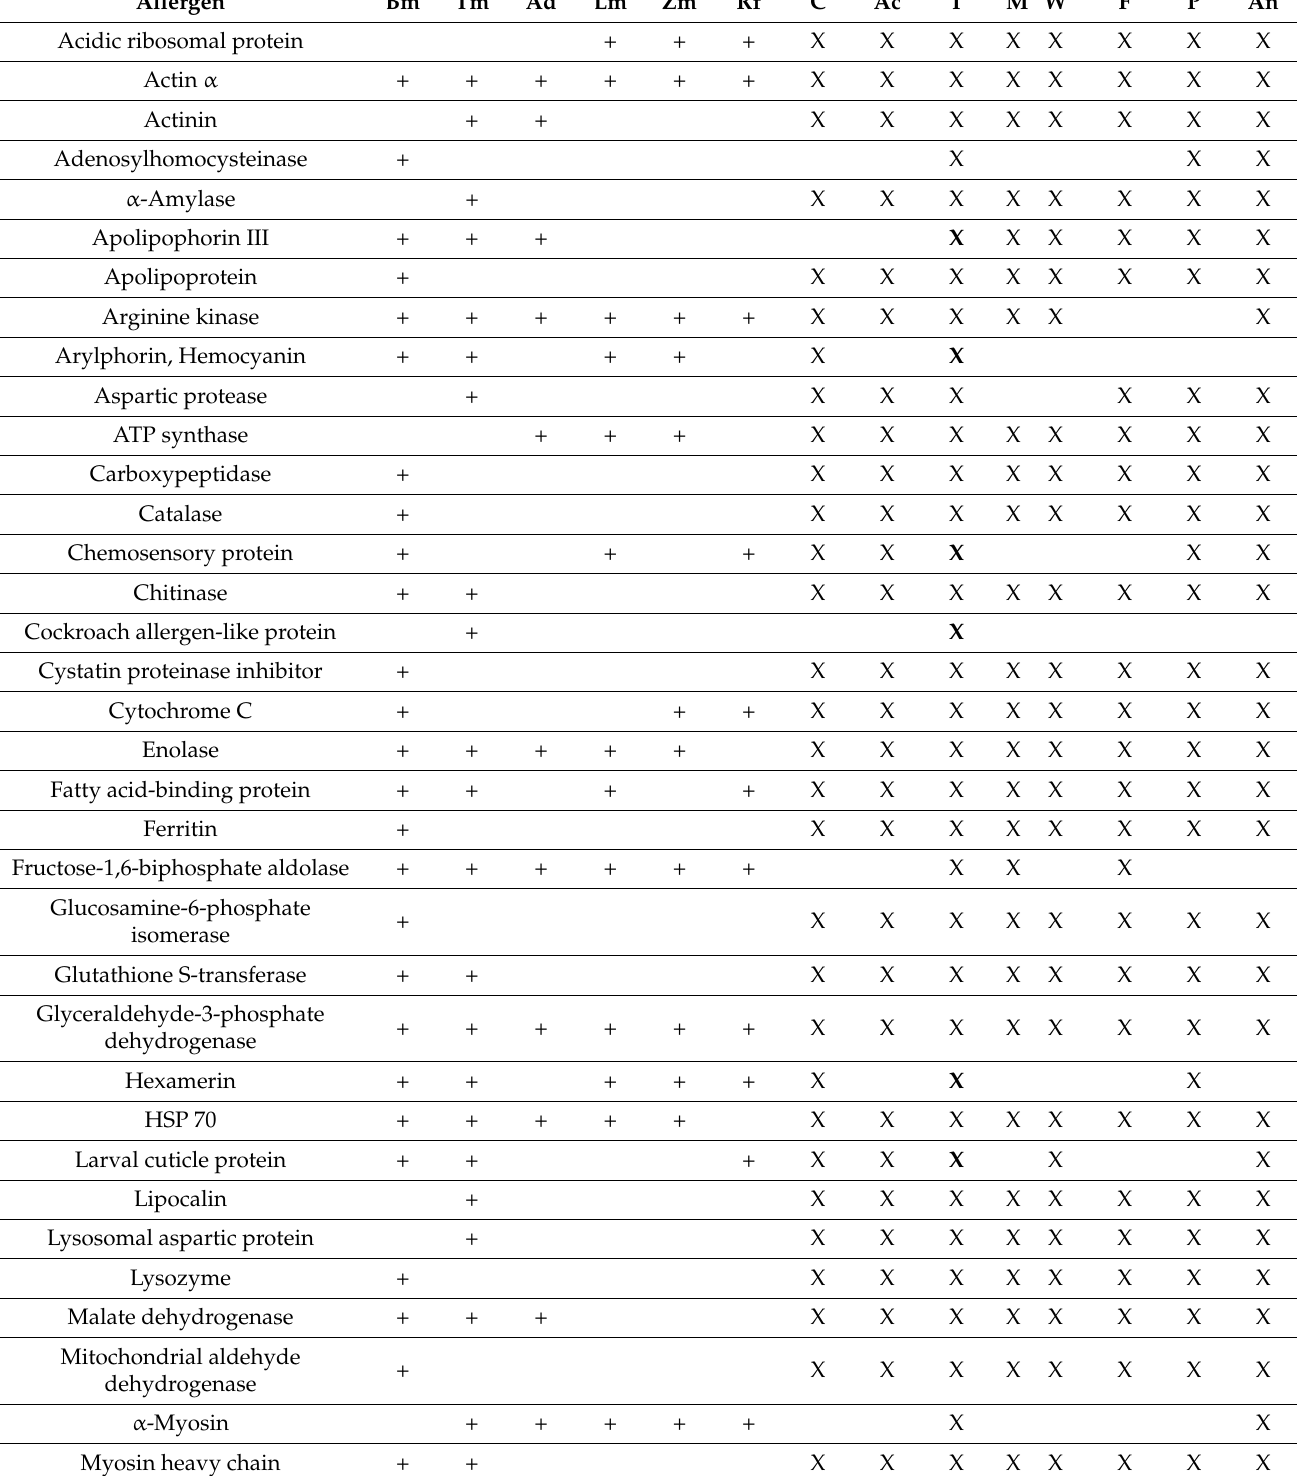
Table 2. List of IgE-binding cross-reactive allergens identified (+) in edible insects (Bm: Bombyx mori , Tm: Tenebrio molitor , Ad: Acheta domesticus , LM: Locusta migratoria , Zm: Zophobas morio , Rf: Rhynchophorus ferrugineus ) shared (X) with crustaceans (C), acari (Ac), insects (I), mollusks (M), worms (W), fungi (F), plants (P) and animals (A). The allergens more specifically distributed in insects are black boxed X